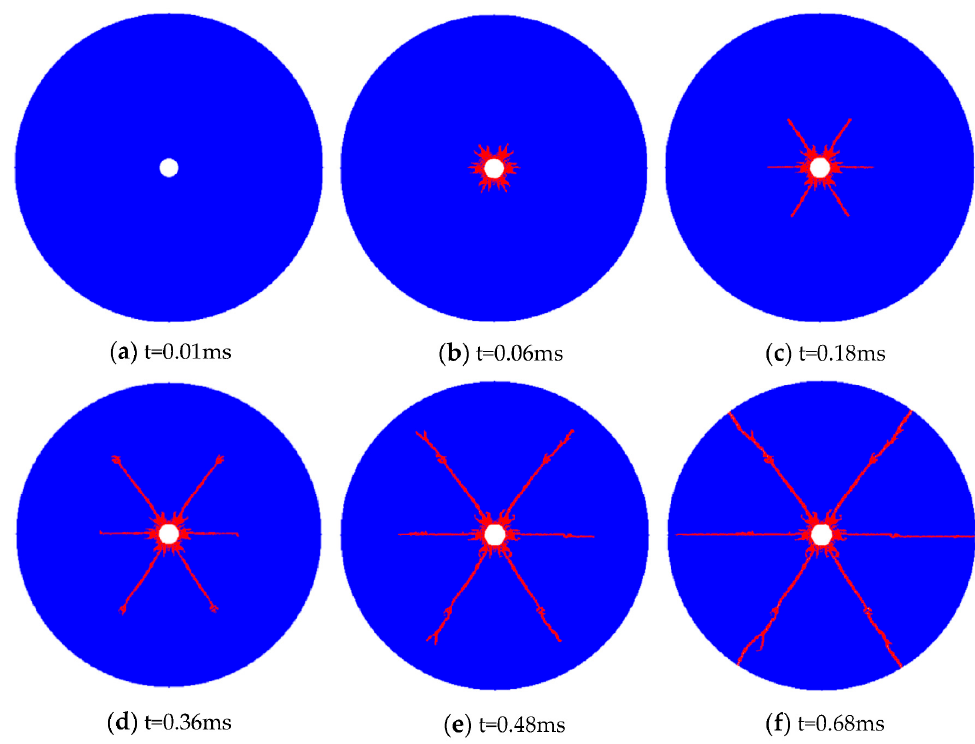
Figure 19. Development process of cracks caused by single-hole non-shaped charge blasting.